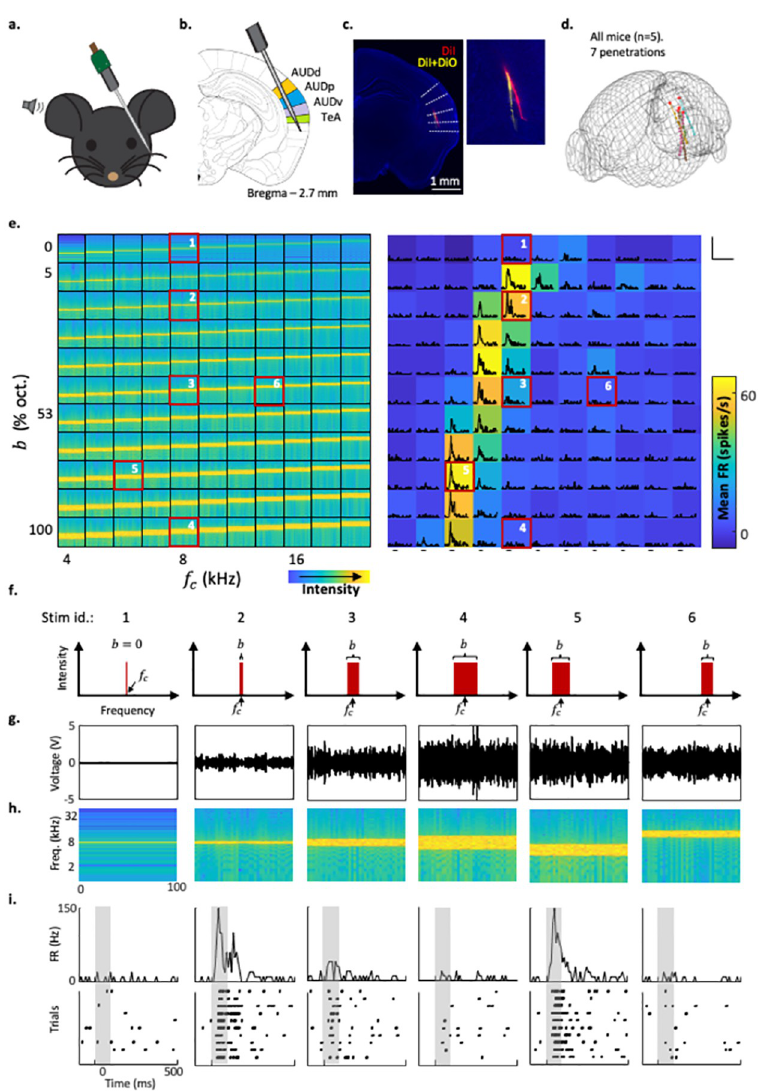
Fig 1. The experimental design—Recordings and stimuli. Schematic representation of the experimental setup. a. Probe penetration setting enabling simultaneous recording of activity from several auditory cortices (AUDp, AUDv, AUDd and TeA; highlighted in color). b. Fluorescent image of a coronal brain slice showing two probe tracks in one mouse. c. Reconstructed trajectories of all probe tracks used in this study (n = 7 penetrations; n = 5 mice). d. Left: spectrograms of all presented BBSs sorted based on bandwidth (Y axis, b ), and central frequency (x axis, f c ). Right: A color-coded FBRA of an example neuron in response to all stimuli shown on the left. e. PSTHs are overlayed on top of the mean response at each pixel location. Black bars on the bottom indicate stimulus presentation time. Scale bars— 150 spikes/sec, and 500 ms. f. Schematic of the spectral profiles of the six stimuli marked in e. g. Voltage traces of the six stimuli marked in e. h. High magnification spectrograms of the six stimuli marked in e. i. Top: high magnification PSTHs of the six stimuli marked in e. Bottom: raster plots matching the PSTHs.